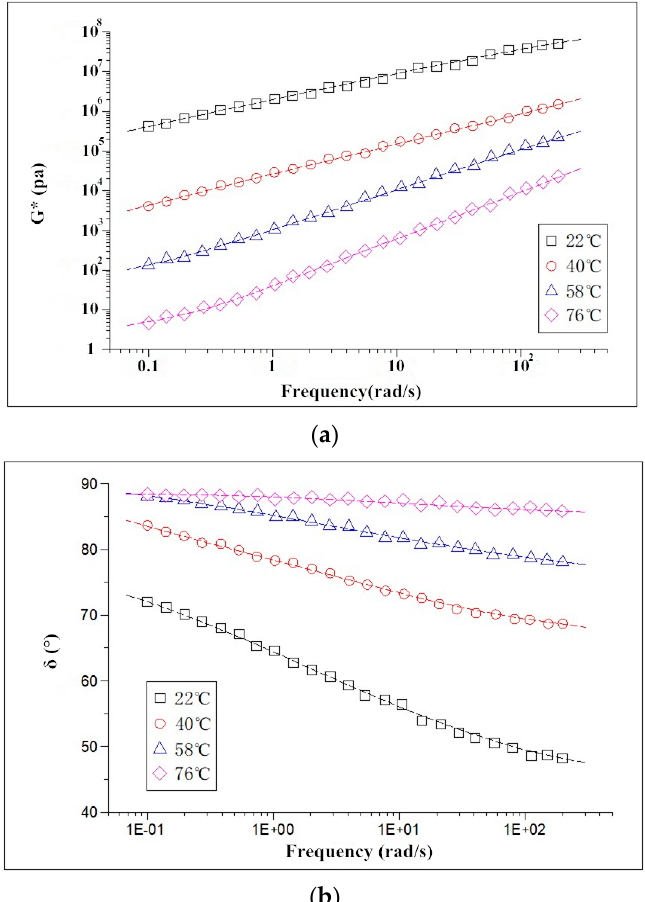
Figure 14. The changes of complex shear modulus and phase angle of base asphalt with frequency. ( a ) complex shear modulus ( b ) phase angle.